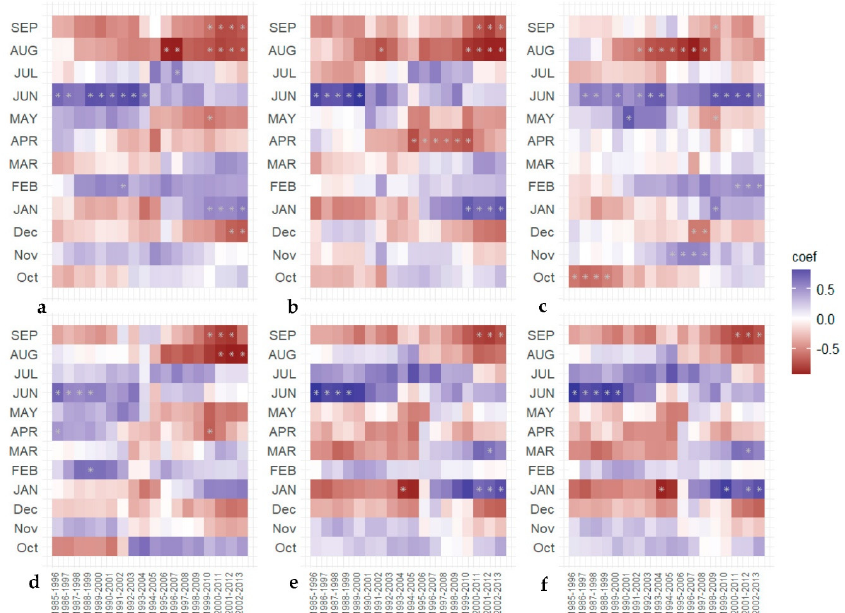
Figure 8. Matrix plots of moving correlation function relating the ring-width index (RWI) of Scots pine ( Pinus sylvestris ) provenances, representing ( a ) eastern, ( b ) central, ( c ) northern, ( d ) southern, ( e ) western locations and ( f ) all provenances, with sums of precipitation, from October in the previous year through September in the current year, over the period 1984–2013. The moving correlation is carried out in windows of 12 years, offset by 1 year. Significant correlations are denoted by asterisks. The precipitation amounts in June had a strong positive statistically significant ef- fect on provenances in all locations in the first 6–10 years of the studied period and a weakened effect at the end of the study period. Accordingly, a statistically significant effect of monthly precipitation amounts in January favored the formation of tree-ring widths starting from 1998 to 2009. This was particularly true for provenances from east- ern, central and western locations (Figure 8a,b,e). In this case, precipitation amounts in February compared to January were more important for provenances in the north. In contrast, precipitation amounts in August and September had a negative, statistically significant effect for provenances in all locations between 1995 and 2006. The effect was the highest for provenance from the eastern location and the least from the western lo- cation. To evaluate the drought effect, we used SPEI 6 with a 6-month accumulation period since it represents a seasonal estimate of drought [61]. The effect of the water deficit on the growth of Scots pine provenances varied over the analyzed period (Figure 9).